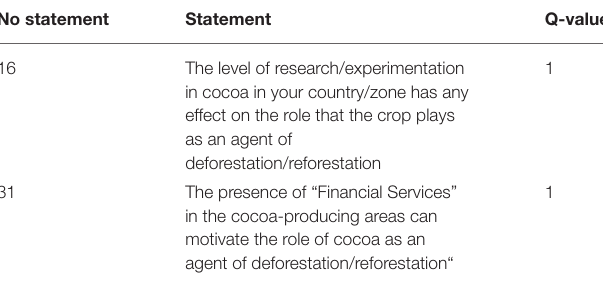
TABLE 5 | Consensus statements* from the discourses of Peruvian interviewed cocoa